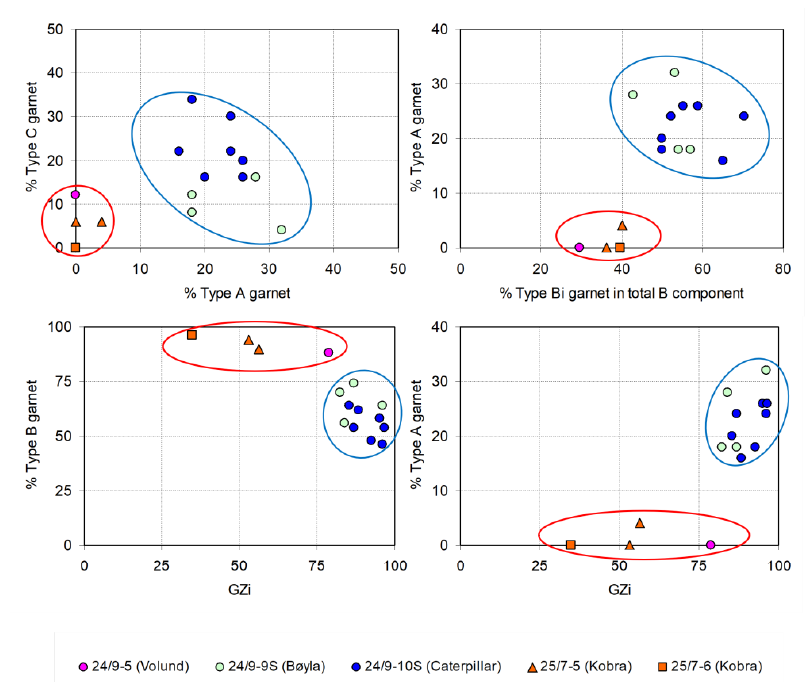
Figure 9. Plots of garnet assemblage compositions and GZi in Hermod S2 sandstones in the